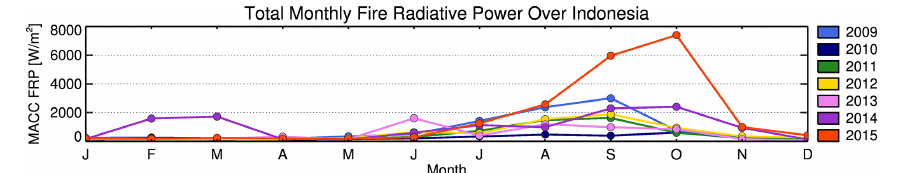
Figure 1. Time series of the monthly total fire radiative power density (Wm − 2 ) recorded over the Indonesian region (defined as 5 ◦ N–10 ◦ S, 90–150 ◦ E) between 2009 and 2015, calculated using data from the CAMS Global Fire Assimilation System (Kaiser et al., 2012). September and October 2015 are clearly anomalous compared to the previous years shown, highlighting the effect of this year’s El Niño on the region’s fire